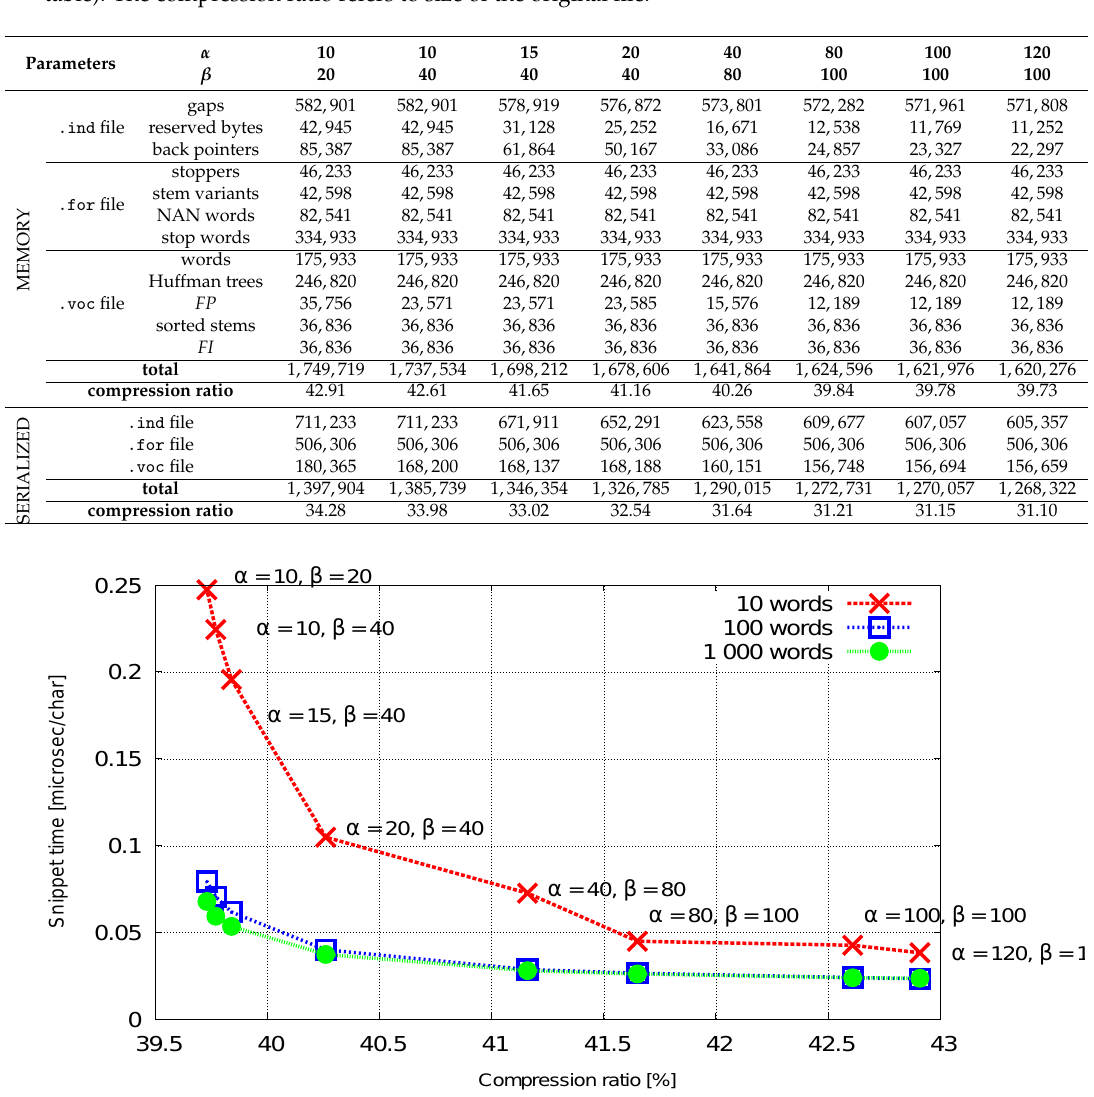
Table 1. PISI space breakdown when performed on bible.txt file. The space is given in bytes (memory consumption in upper part of the table and the disk storage consumption in lower part of the table). The compression ratio refers to size of the original file.